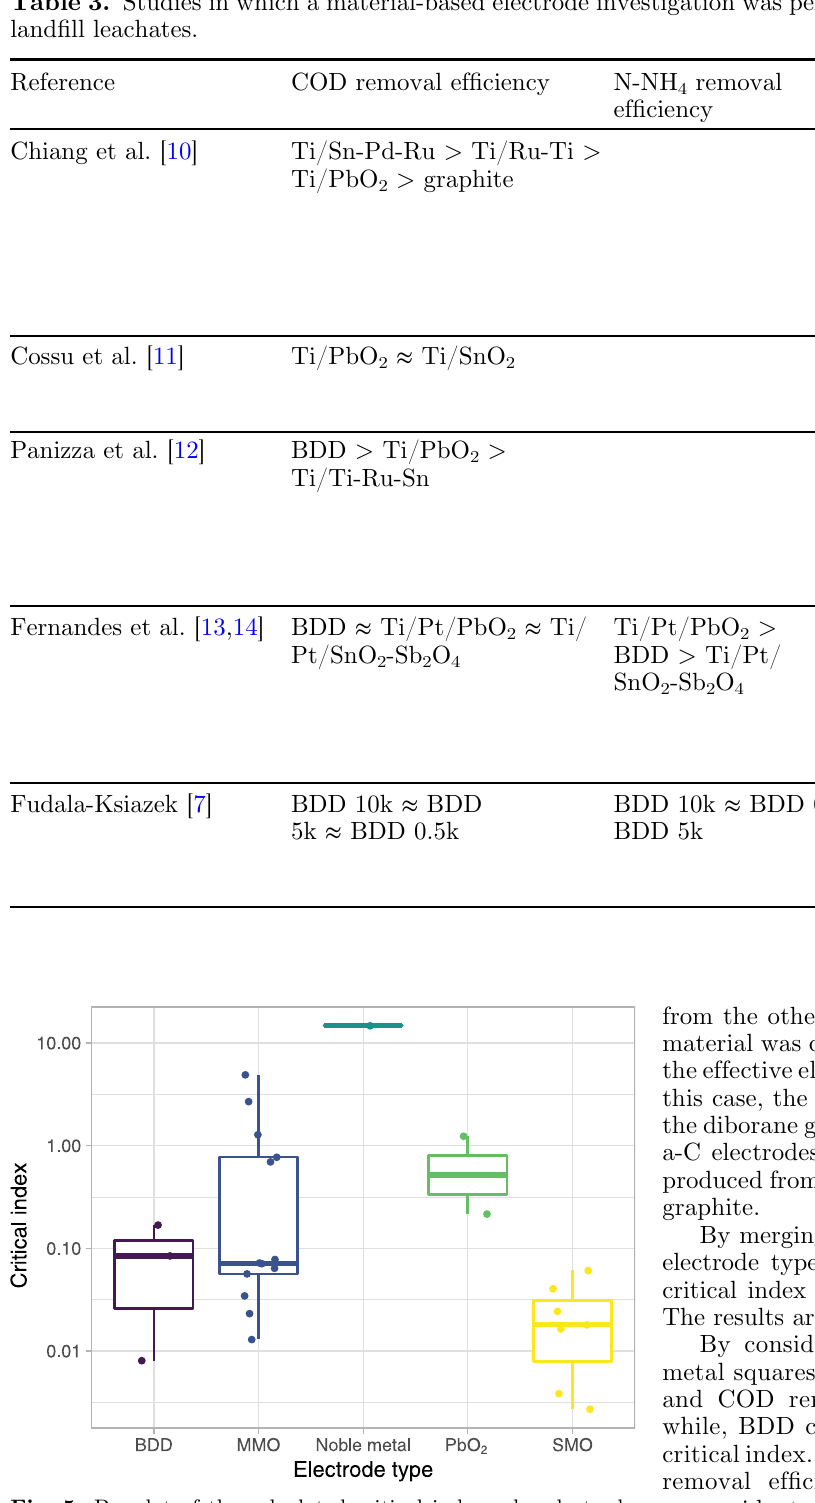
Fig. 5. Boxplot of the calculated critical indexes by electrode